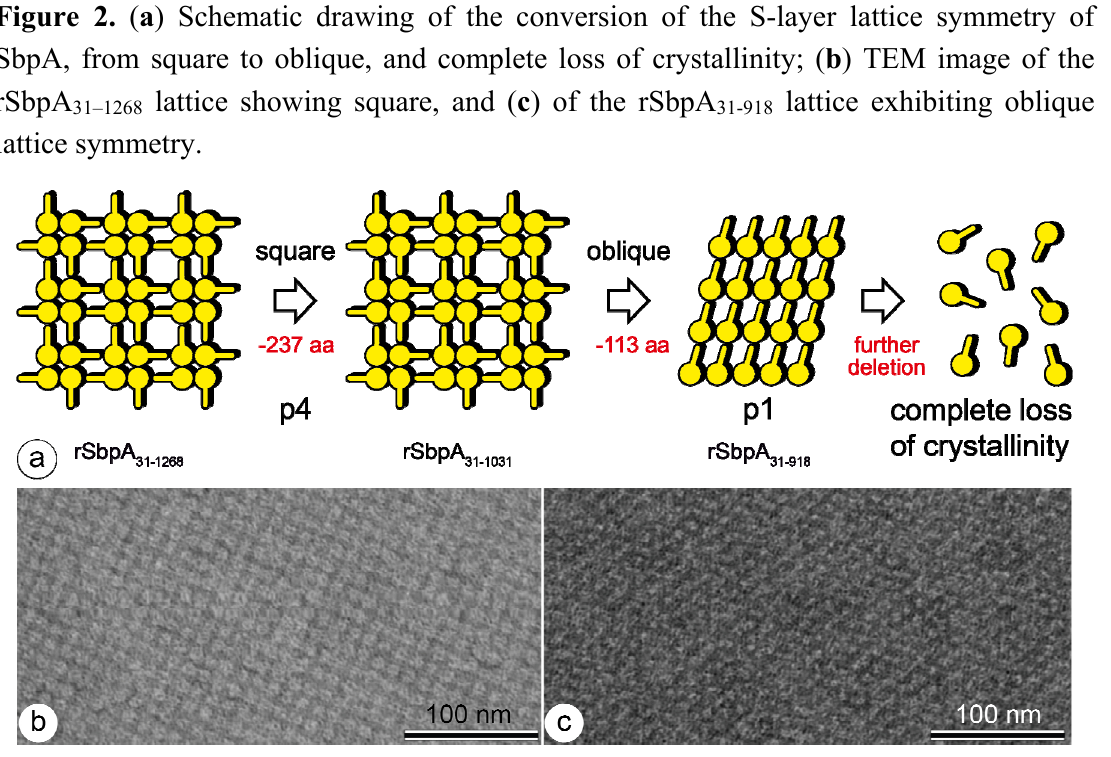
lattice exhibiting oblique 31-918